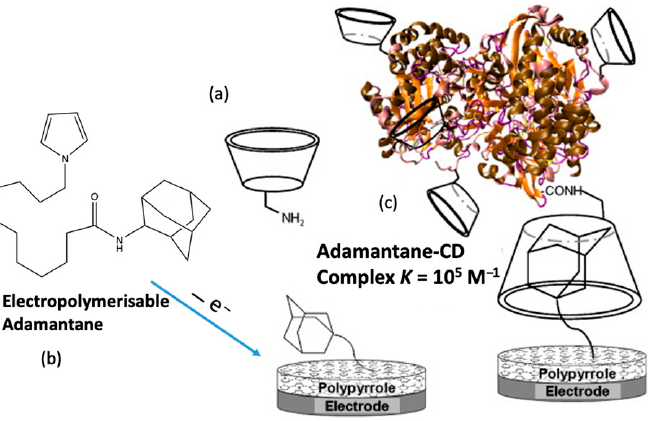
Figure 8. Supramolecular assembly of β -CD tagged glucose oxidase (GOX) and an adamantine-modified electrode: ( a ) representation of mono-6-amino- β -CD, ( b ) electrogeneration of poly(adamantane-pyrrole), and ( c ) polymerized adamantane/ β -CD complex. Reproduced with permission from Cosnier and coworkers [119], Biosens. Bioelectron.; published by Elsevier, 2009. Thiol groups serve as very good linkages enabling the attachment of CDs and polythi- olated CDs to the biosensor surface [166]. If the entire surface is covered, this hydrophilic surface layer (due to the hydrophilic exterior of the CD) reduces considerably the nonspe- cific interactions, and this is especially important in the development of